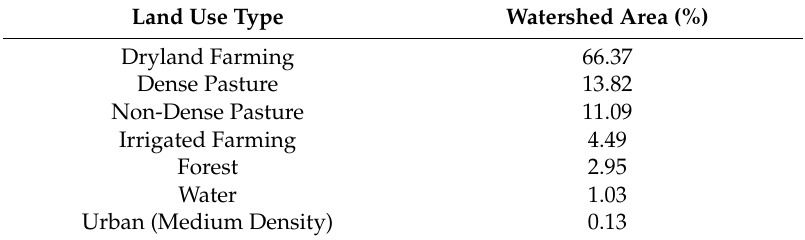
Figure 2. ( a ) A soil map and ( b ) land use map of the Mahabad Dam watershed. Tables 1 and 2 represent the land use and soil classification of the watershed, respectively. Table 1. The land use classification of the Mahabad Dam watershed.